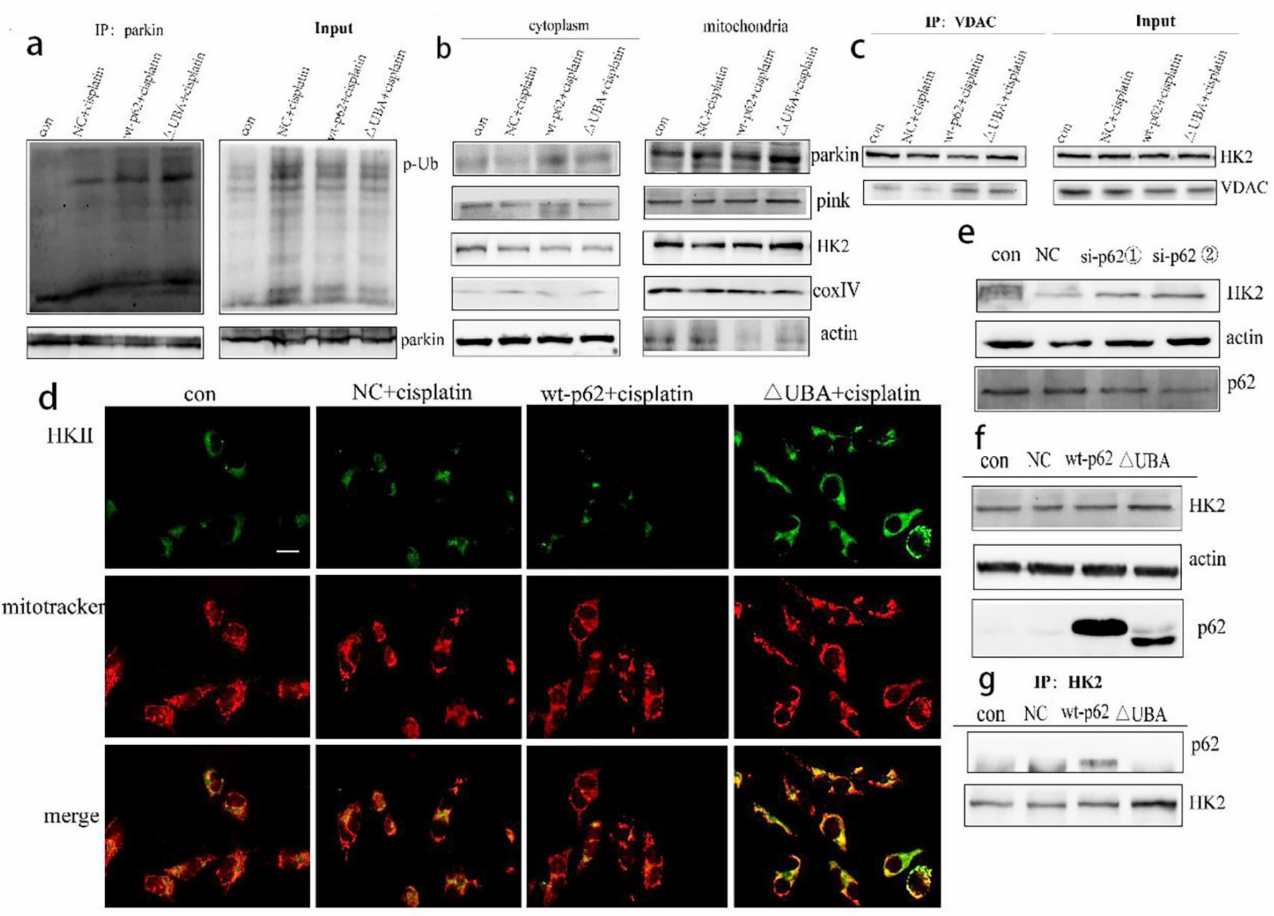
Figure 5. Increased recruitment of HK2 and p-Ub-parkin on mitochondria after mutating UBA domain. ( a ). A2780 cells transfected with wt-p62 or ∆ UBA-p62 and treated with cisplatin 5 µ g/mL for 8 h. Immunoprecipitation was performed with the anti-phosphorylated ubiquitin (p-Ub) antibody followed by Western blotting using anti-p-Ub, anti-HK2. ( b ). A2780 cells were transfected with wt-p62 or ∆ UBA-p62. Western blot analysis of pink1, parkin, HK2, actin and coxIV in cell lysate and mitochondrial lysate in A2780 after treatment (cisplatin 5 µ g/mL, 8 h). ( c , d ). A2780 cells transfected with wt-p62 or ∆ UBA-p62 and treated with cisplatin 5 µ g/mL for 6 h. The colocalisation between HK2 and mitochondrial was detected by immunoprecipitation and immunofluorescence, which was observed by Western blotting and microscope. Scale bar, 10 µ m. ( e , f ). A2780 cells transfected with si-p62 and wt-p62 or ∆ UBA-p62. The expression of HK2 was detected by Western blotting.si-p62 1 (cid:13) , 2 (cid:13) were purchased from Sangon Biotech ( g ). A2780 cells transfected with wt-p62 or ∆ UBA-p62 and treated with cisplatin 5 µ g/mL for 12 h. Immunoprecipitation was performed with the anti-HK2 antibody followed by Western blotting using anti-p62,